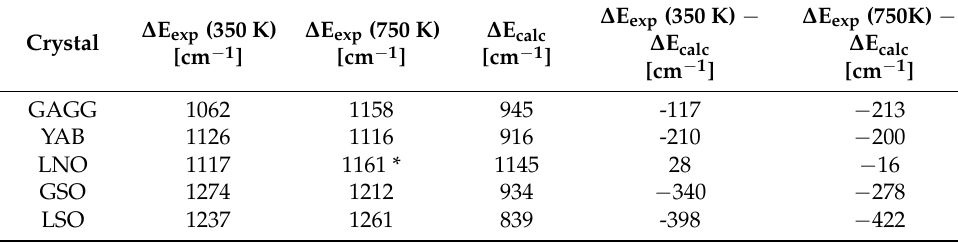
Table 4. Calculated and experimental values of the energy gap ∆ E between thermally coupled levels of Dy 3+